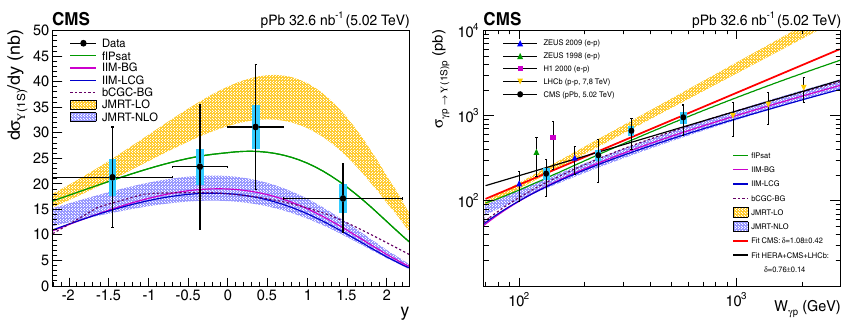
Figure 2. Left plot is the background substracted di ff erential cross section as a function of rapidity measured in pPb collisions. Right plot is the W γ p dependence of cross section for the exclusive photo production [5].